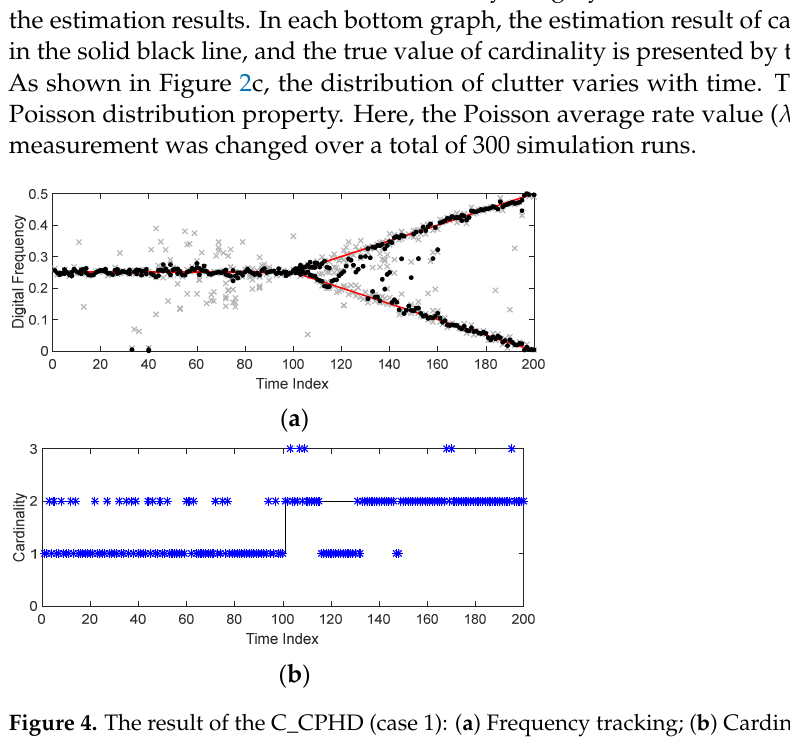
Figure 4. The result of the C_CPHD (case 1): ( a ) Frequency tracking; ( b ) Cardinality estimate.